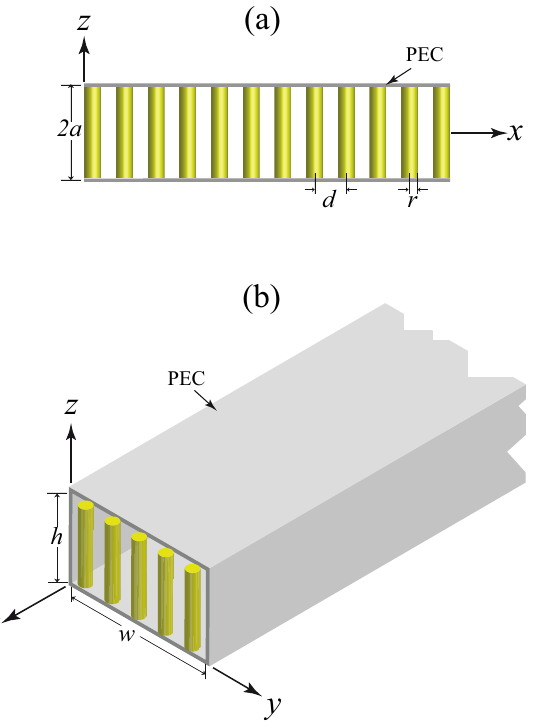
Figure 1. ( a ) Side view of a planar slab of nanowire-based HMMs. The array of nanowires has areal density N with axes parallel to z -axis. Also, r is the radius of a nanowire and d nanowires. The PEC interfaces separating the slab ( filled with a medium of nanowire-based HMMs with its appropriate dimensions and PEC